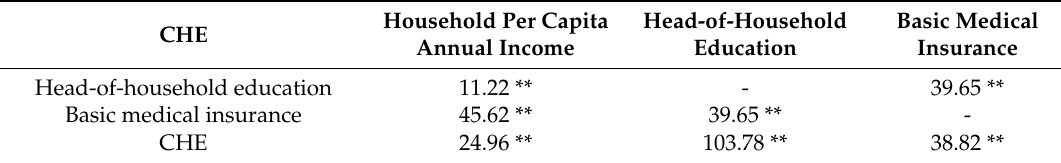
Table 3. Correlation analysis of the research